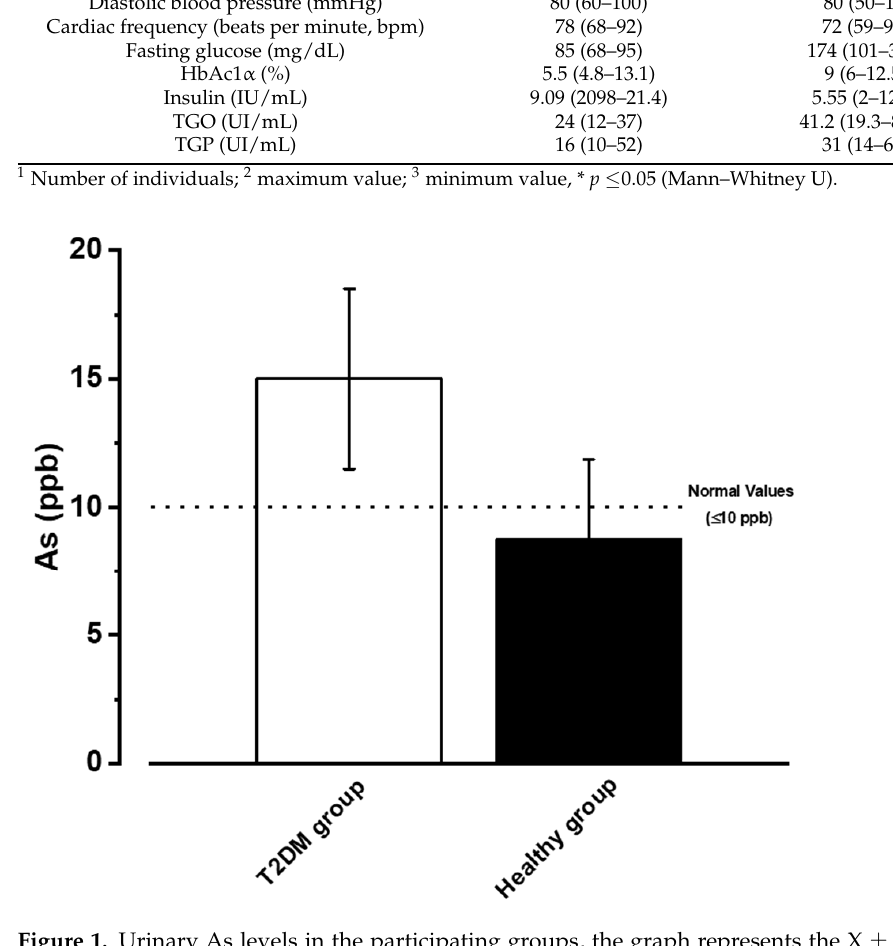
curve (T2DM; light green line) concerning group 1 (healthy; dark green line); see Figure 2. The data were corroborated by analyzing the population pharmacokinetic parameters, group ( p = 0.0312), while Ka was 3.7824 times higher ( p = 0.000023) and Cl was 0.781 ( p = 0.0015) times higher in the healthy group vs. T2DM group, as shown in Table